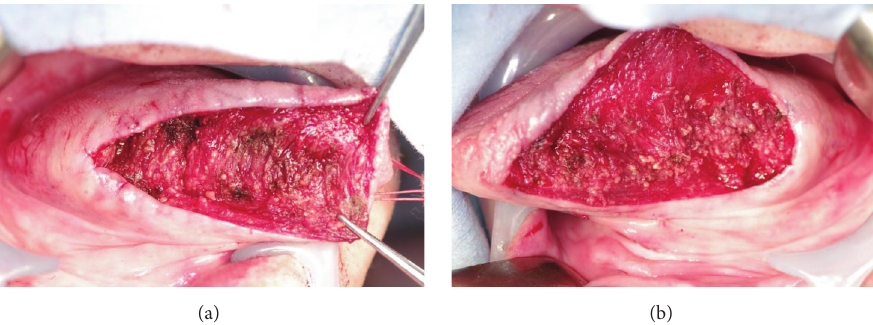
Figure 4: Intraoperative view. After bilateral partial glossectomy (tumor excision).